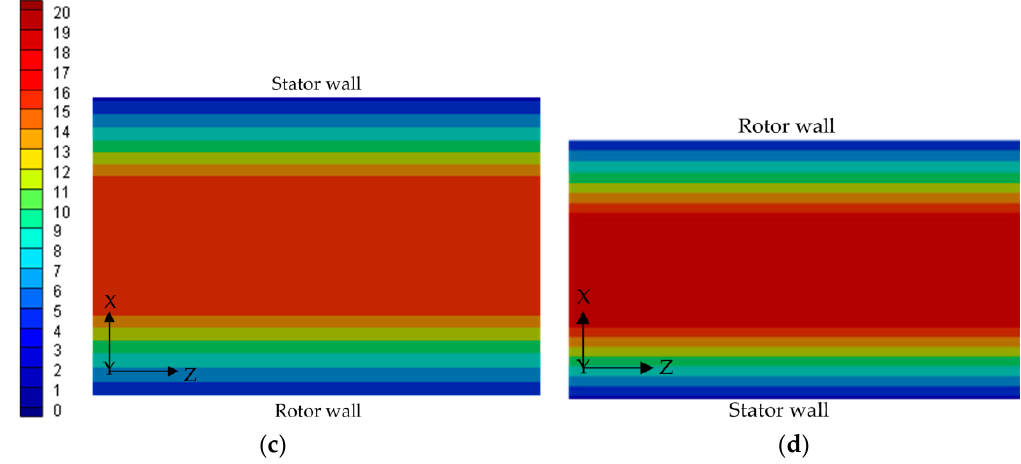
Figure 12. Z-direction velocity profile of the long seal (PD = 1.38 MPa): ( a ) the maximum clearance cross section, ( b ) the minimum clearance cross section, [L = 76.2 mm], ( c ) the maximum clearance cross section, ( d ) the minimum clearance cross section, [L = 91.44 mm]. Table 2. The dynamic characteristics under different seal lengths.